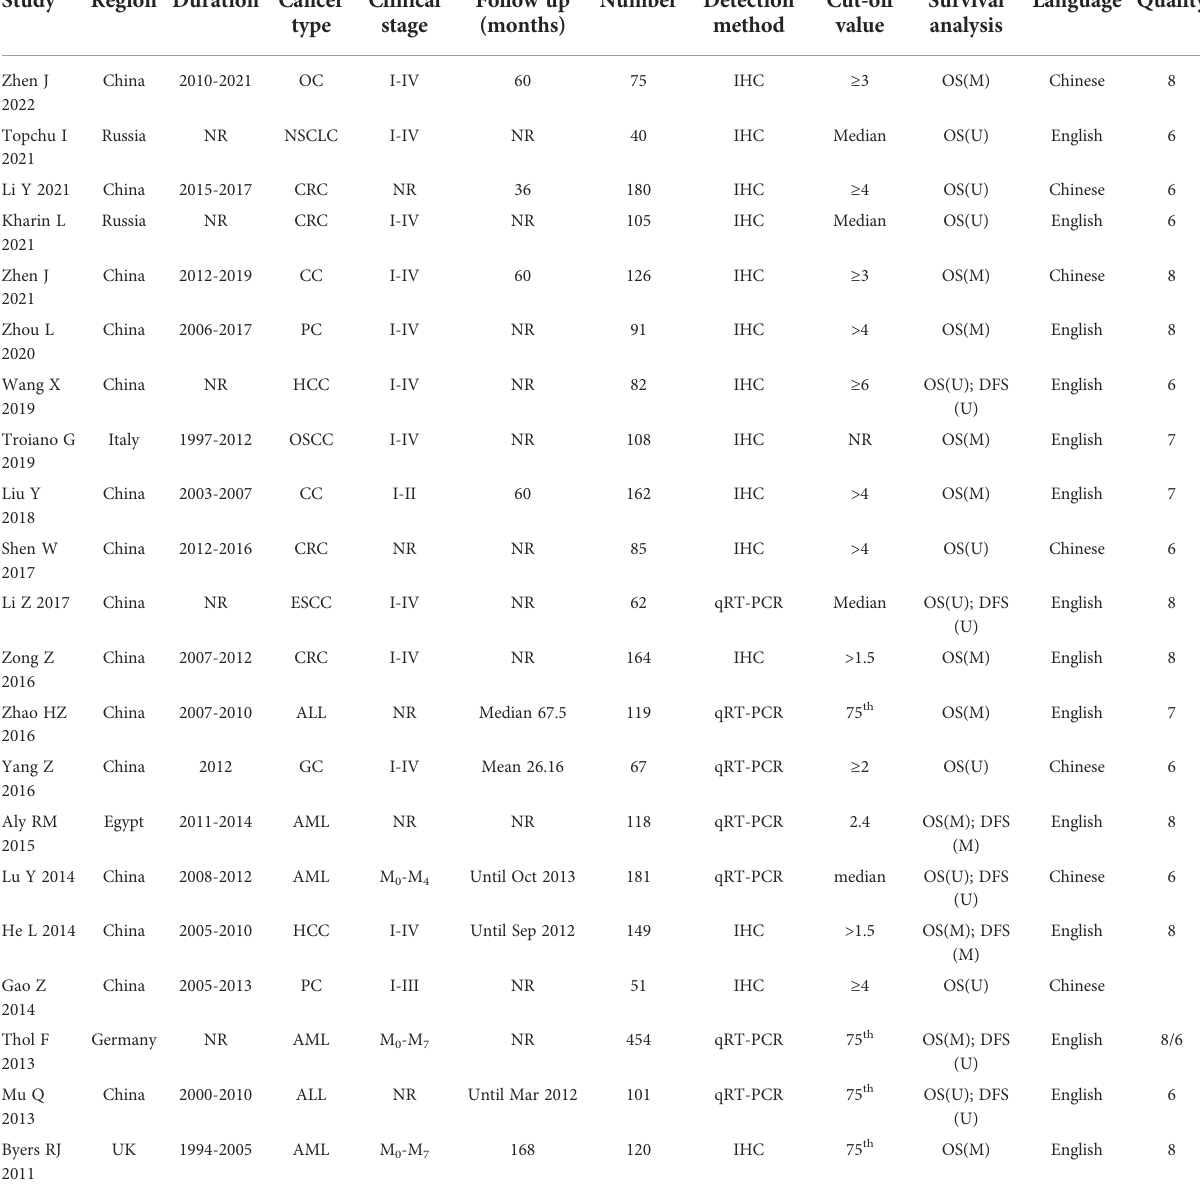
TABLE 1 Main characteristics of the eligible